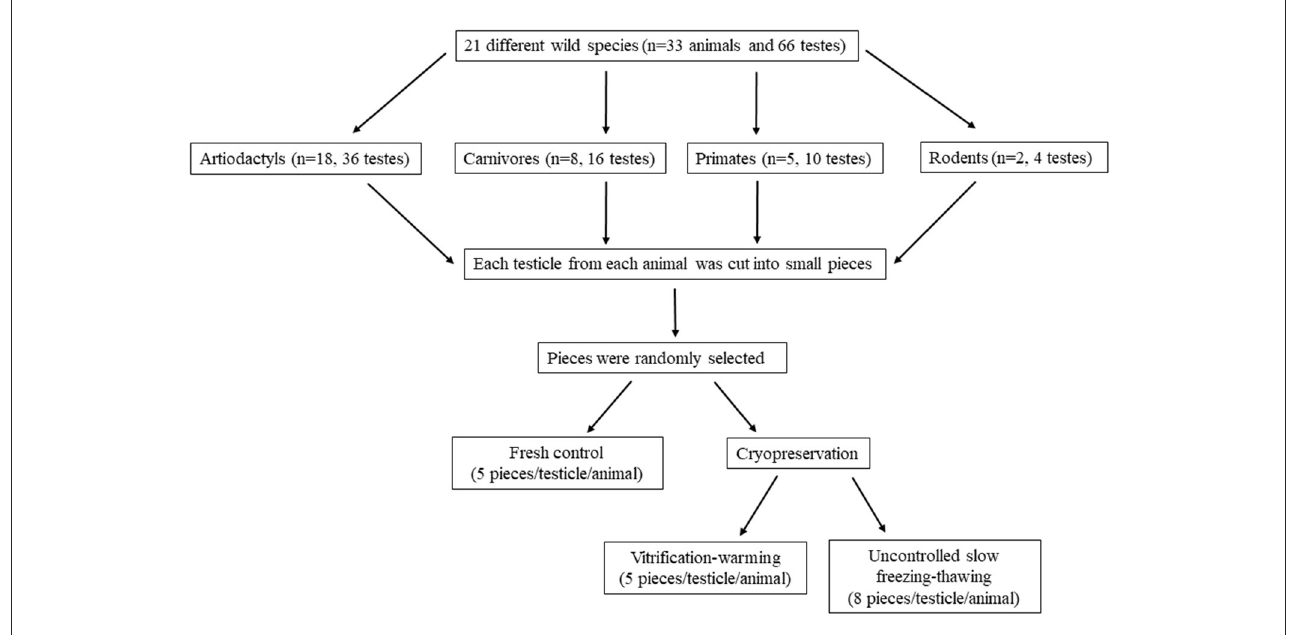
FIGURE1 Flowchart showing the experimental